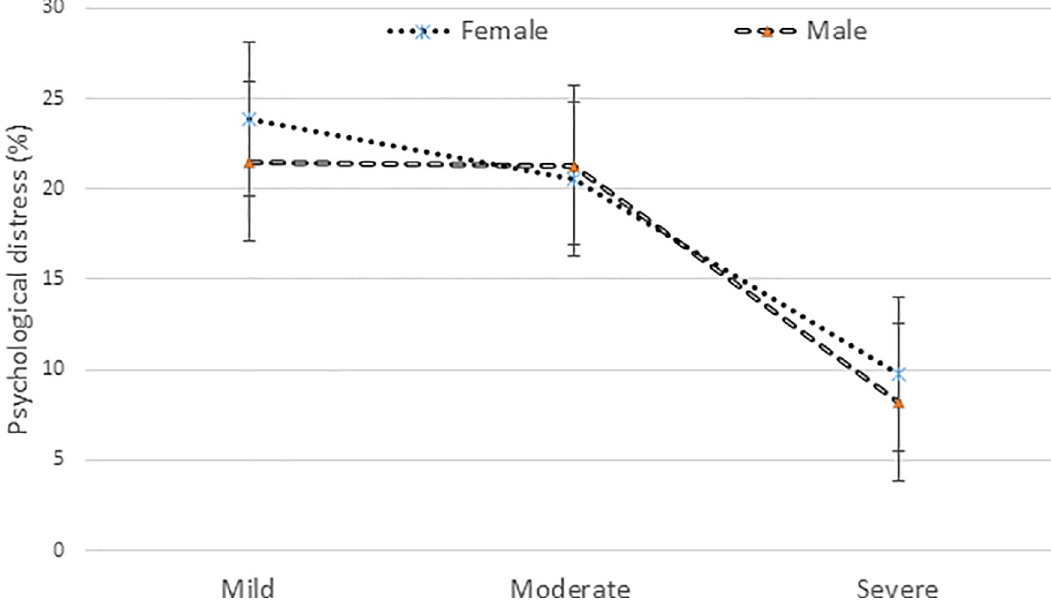
Fig 1. Different levels of psychological distress in males and females in total sample.